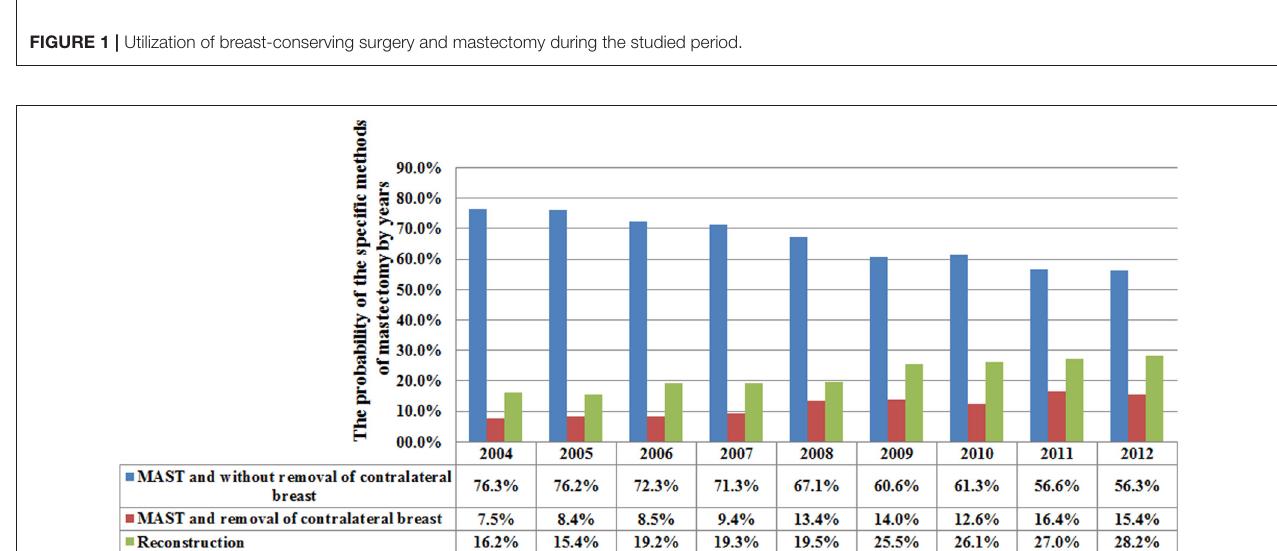
FIGURE 2 | Utilization of specific mastectomy procedures during the studied period.